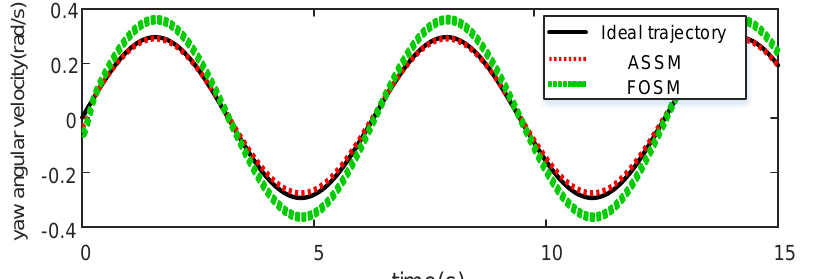
Figure 7. Yaw angular velocity.